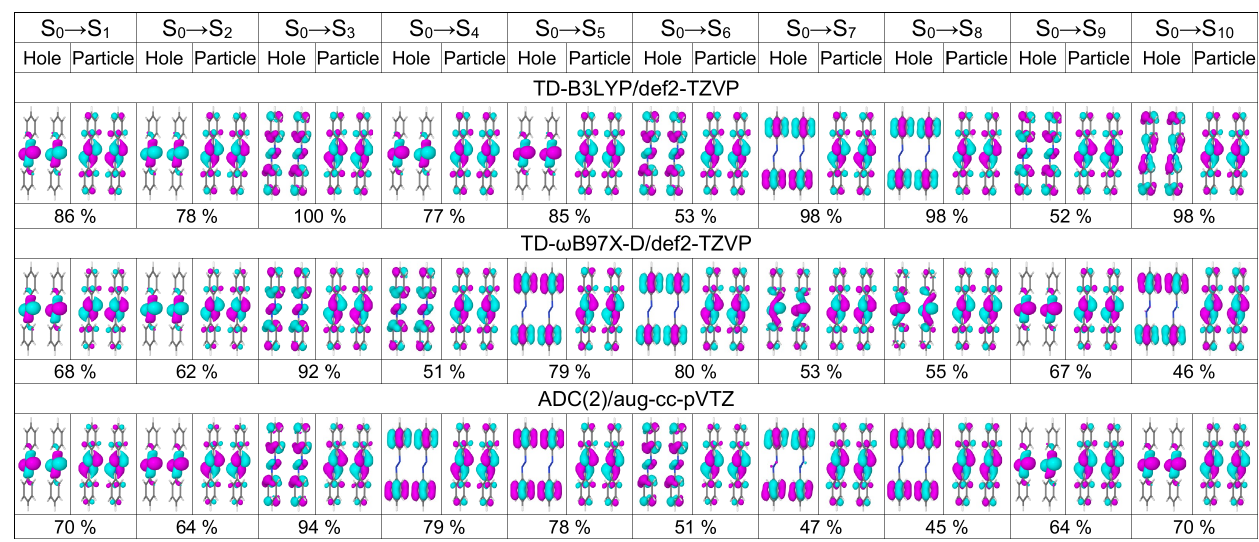
Figure 5. Dominant natural transition orbital pairs for the lowest ten transitions of the cofacial π -stacked dimer d = 3.5 Å calculated at the TD-B3LYP/def2-TZVP ( top row ), TD- ω B97X-D/def2-TZVP ( middle row ), and ADC(2)/aug-cc-pVTZ ( bottom row ) levels of